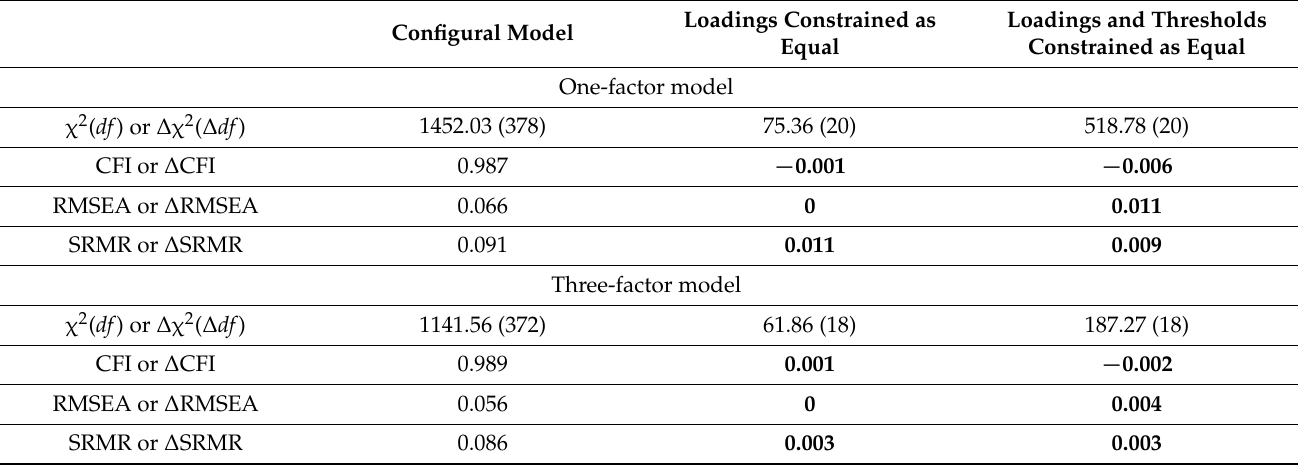
Table 5. Fit indices for measurement invariance across freshmen from two data